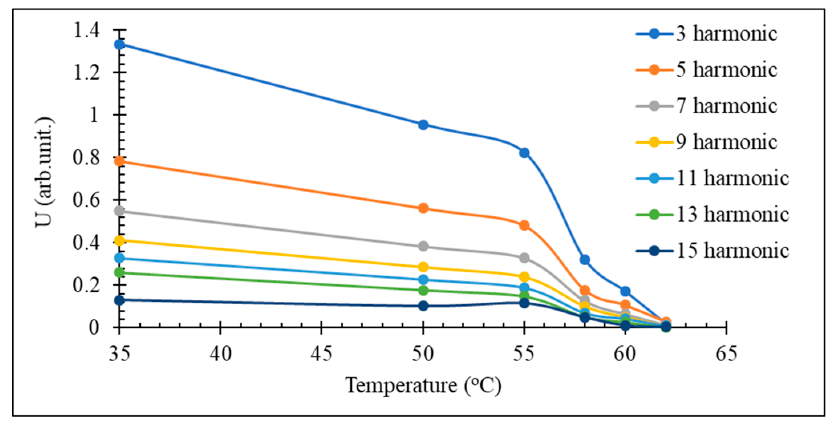
Figure 14. Harmonic spectrum vs. temperature of glass-coated amorphous Fe 3.9 Co 64.82 B 10.2 Si 12 Cr 9 Mo 0.08 microwire having T C = 61.5 °C in an as-prepared state.